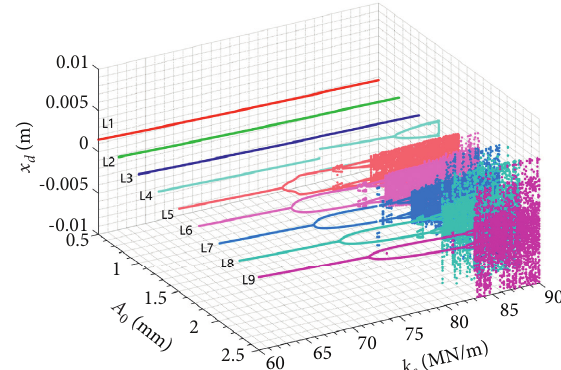
Figure 14: Bifurcation diagrams with the subgrade stiffness k bifurcation parameter under different nominal amplitudes ( f � 32Hz and c s �